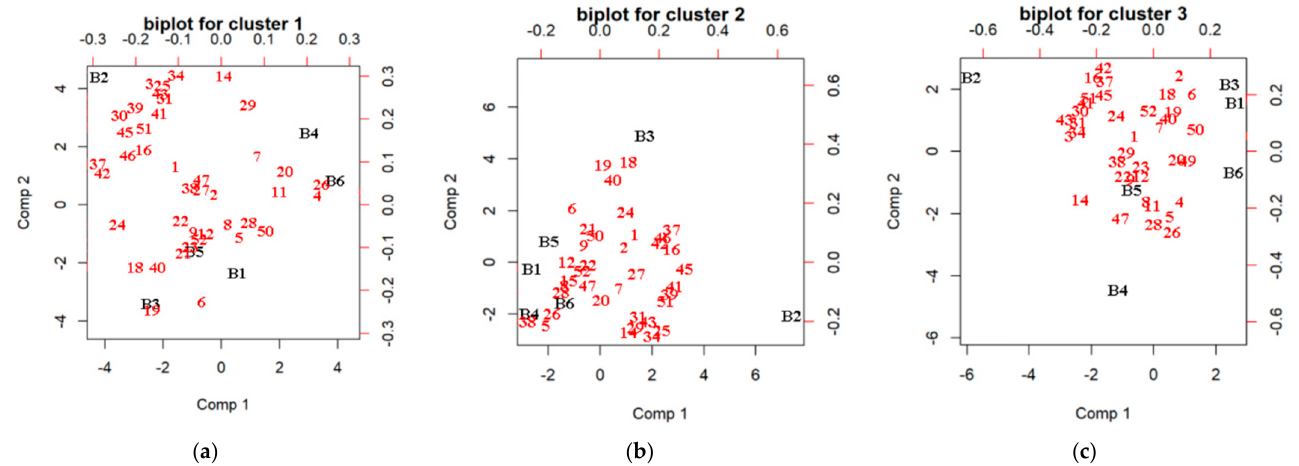
Figure 8. The biplot of each cluster ( a − c ) by partial least squares regression analysis (n = 30 for cluster 1, n = 18 for cluster 2 and n = 28 for cluster 3). The vinegar code corresponds with Table 1. The number of compounds corresponds with Table 2. Table 7. The relative importance of the top five most important volatiles in three clusters.